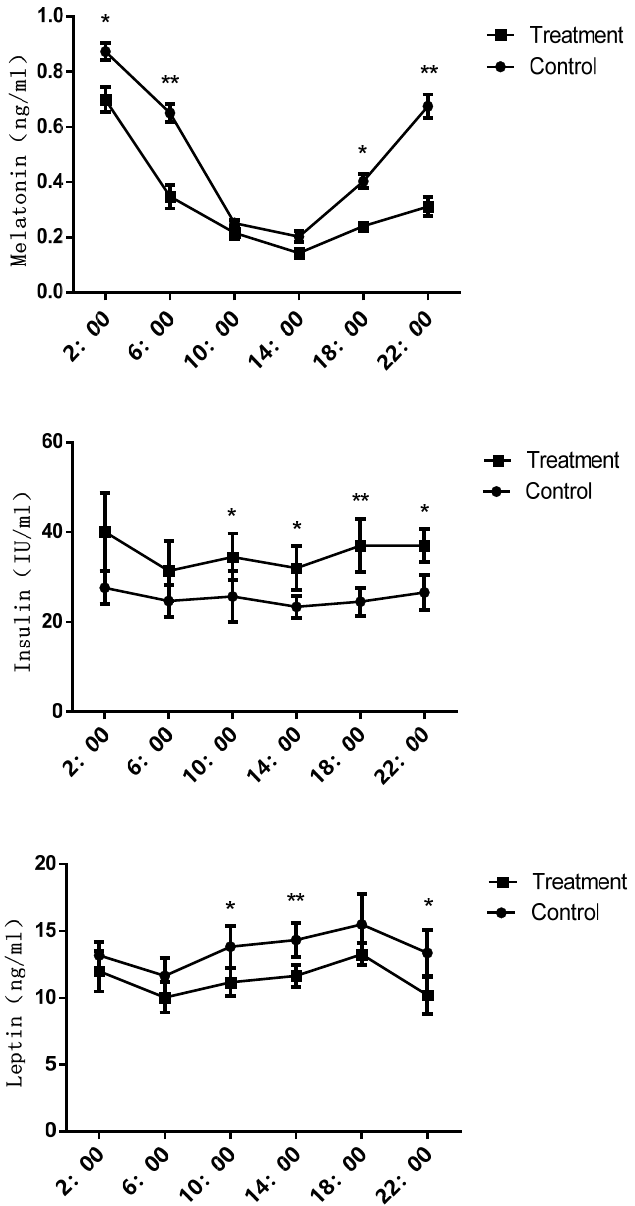
Figure 1. Effects of prolonged photoperiod on blood lipid metabolism related hormone levels in Jinjiang cattle in winter. The data has been shown as the mean±standard error of six replicates, * and ** mean values within different letters were significantly different (p<0.05) and (p<0.01). 526 Table 5. Effects of prolonged photoperiod carcass traits of Jinjiang cattle Traits Control Treatment p-value Marbling